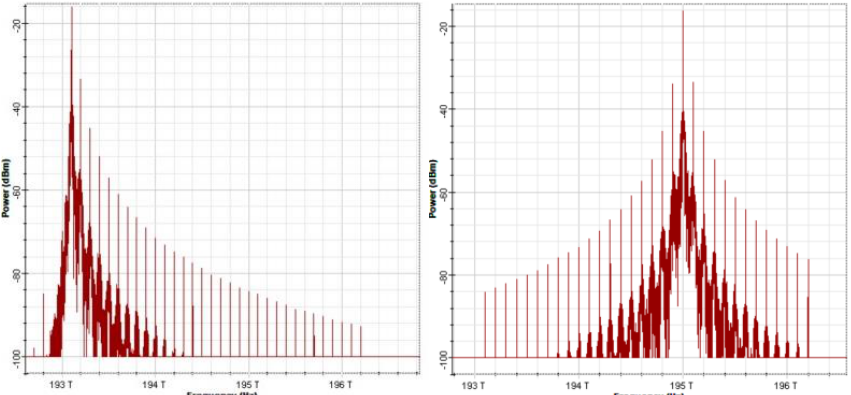
8 of 15 Figure 3. EDFA model in our DWDM system. Table 9. Results of 32-channel EDFA DWDM system. Parameters